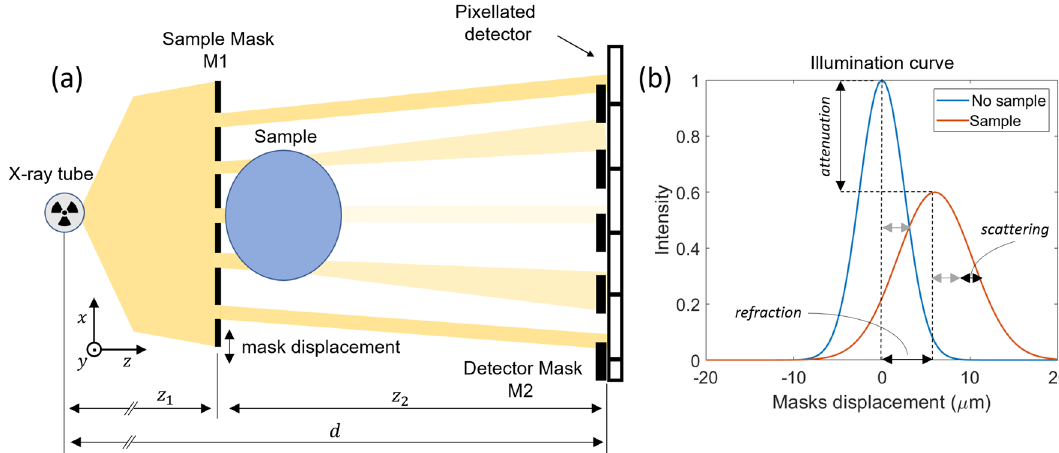
Figure 1. In ( a ) a sketch (not to scale) of a double-mask EI setup: due to the sample each beamlet is reduced in intensity (attenuation), deflected (refraction) and diffused (dark field). In ( b ) the characteristic illumination curves obtained by displacing the masks without (light blue) and with (orange) the sample in